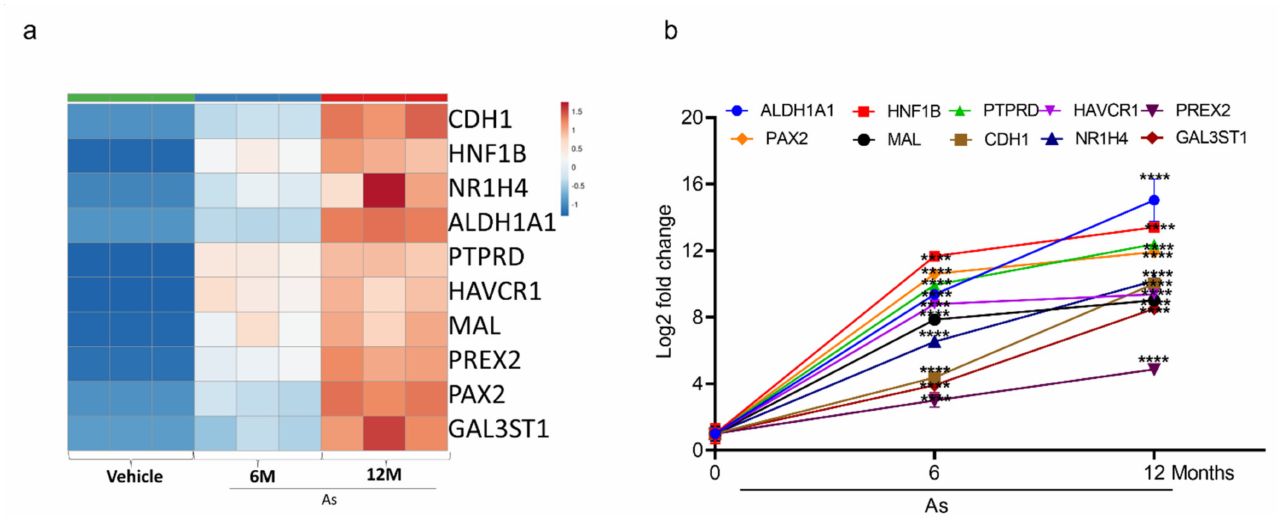
Figure 4. Expression validation of selected genes (RNA-seq datasets) using qRT-PCR. Heatmap analysis showing the expression level of top 10 upregulated genes ( a ) in RNA-seq datasets. The expression for upregulated genes ( b ) was determined by quantitative RT-PCR in successive stages of transforming cells (0, 6, and 12 months). Expression levels were normalized to β -actin. Error bars indicate the standard deviation of triplicates. One-way ANOVA was used to calculate the statistical significance between vehicle control and treatment at each time point. (**** p <